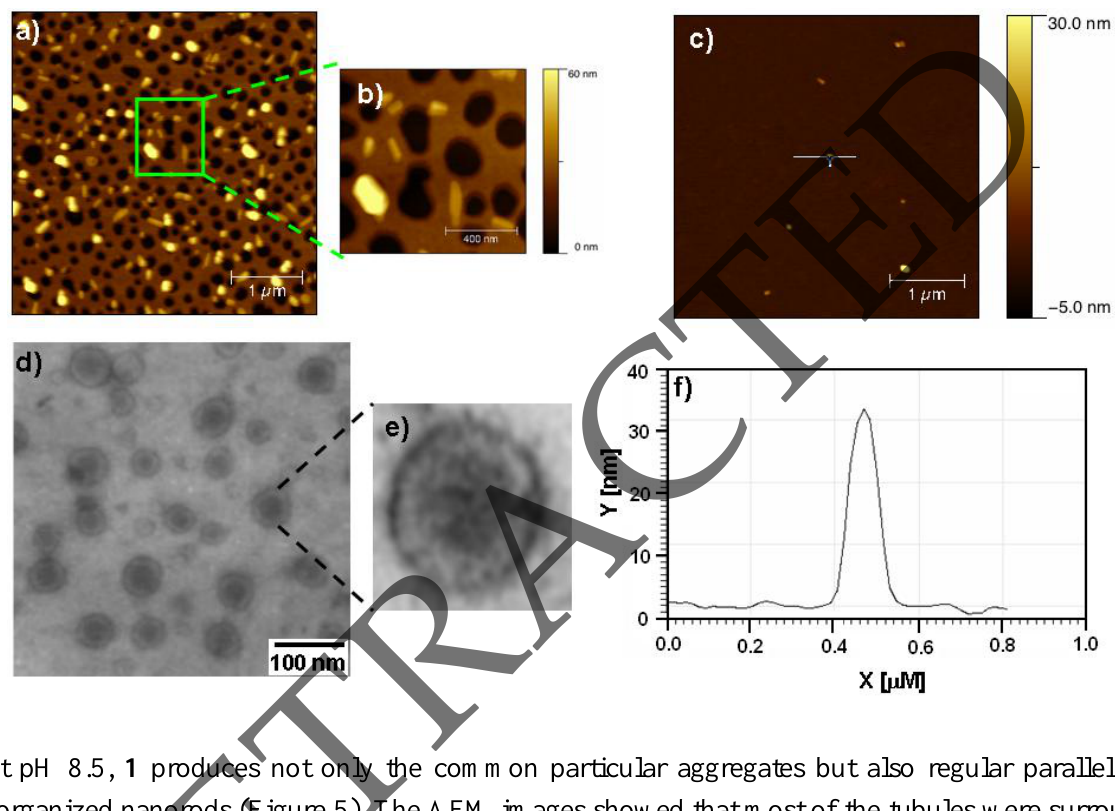
Figure 4. Atomic force microscopy (AFM) height images of OctaPhosPor 1 (10 −4 M) upon spin-cast on silicon wafer plate after the solvent has evaporated, gives nanospheres in water at pH 7.0: ( a ) height image (scale bar = 1  m); ( b ) magnified view of height image a (scale bar = 400 nm); ( c ) height image (scale bar = 1  m); ( d ) Transmission electron microscopy (TEM) micrograph of 1 on holey, carbon-coated copper grids (scale bar = 100 nm); ( e ) high magnification of d; and ( f ) cross-section analysis magnified region from image c, provides a mean diameter of ca. 75 nm and a height of 30